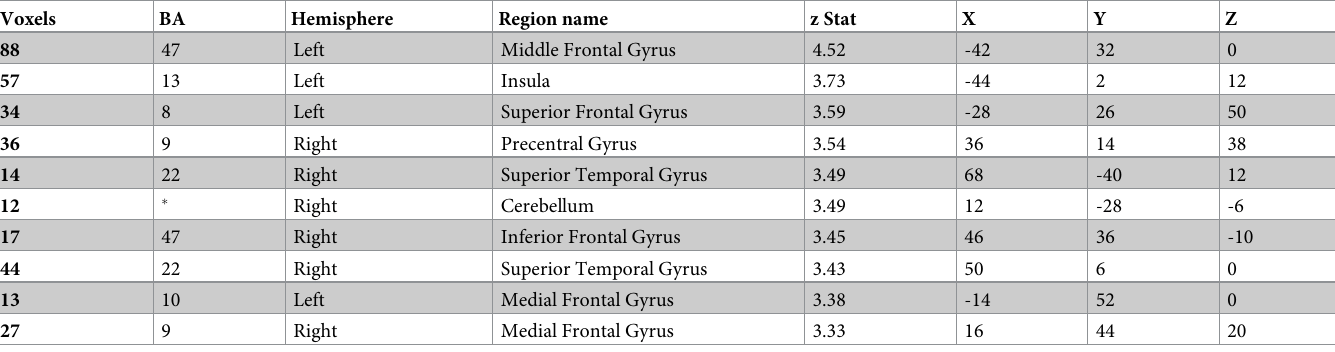
Table 5. Activation peaks for regions showing proportionate activation for TD during both encoding and remote retrieval ( p < .001).